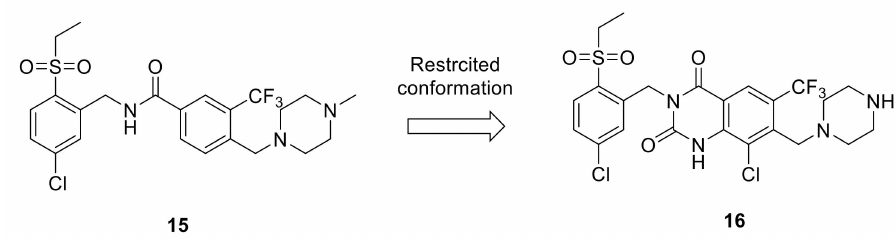
Figure 5. Restricted conformation strategy and chemical structures of compounds 15 and 16 .